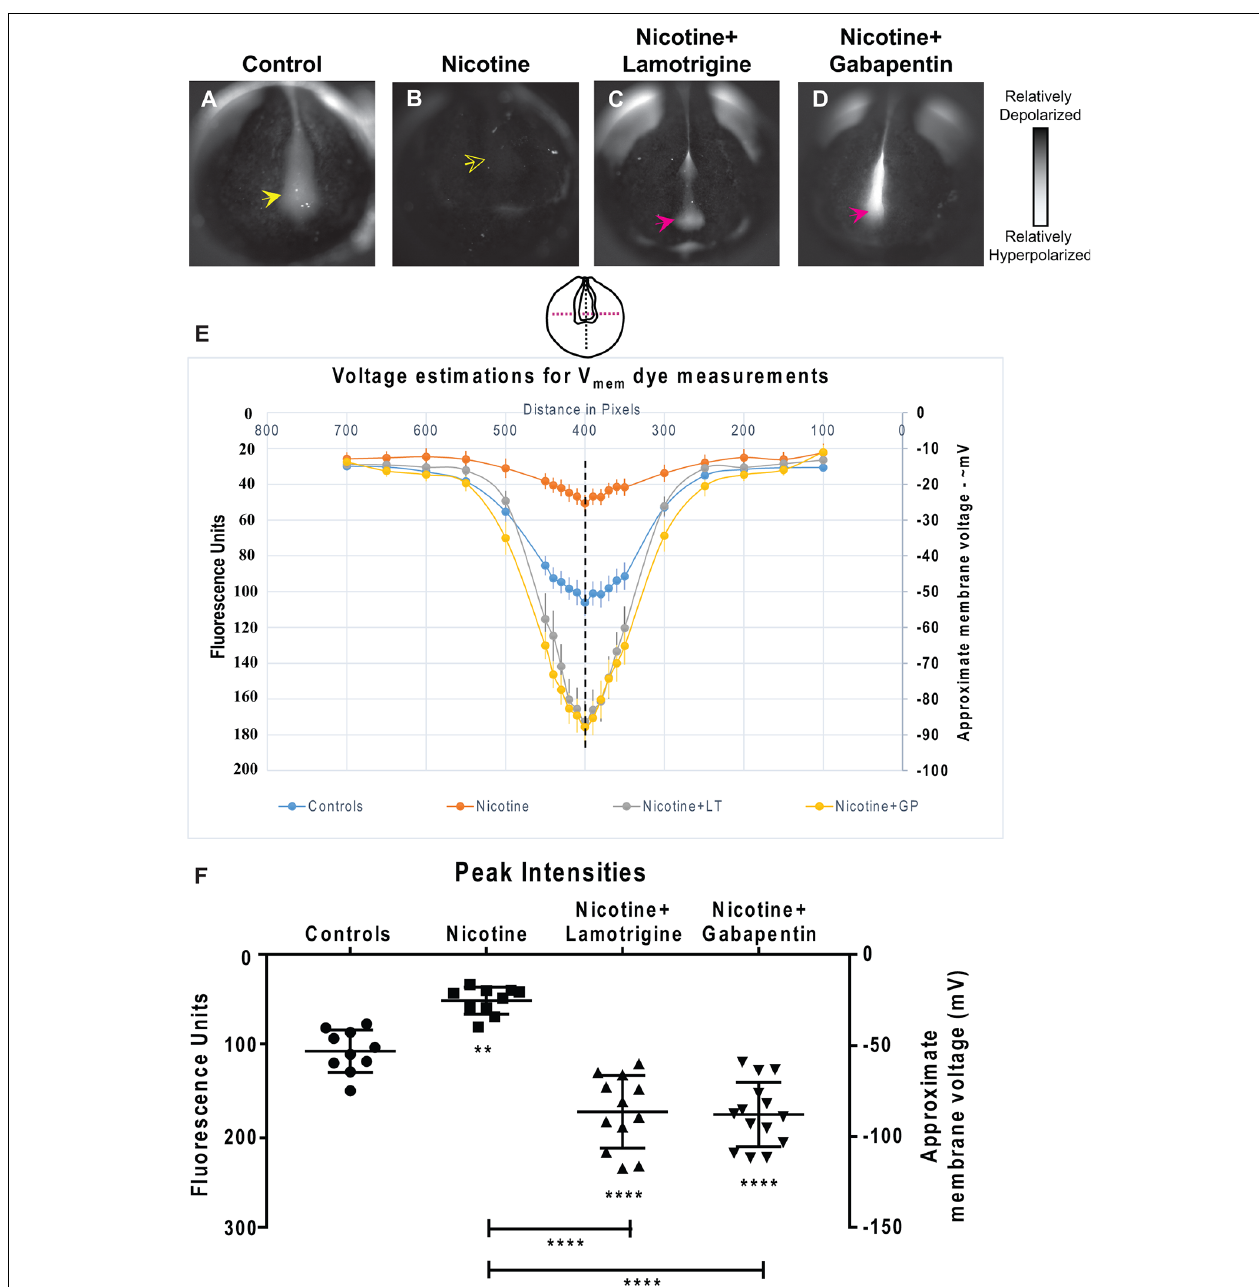
FIGURE 9 | Lamotrigine and Gabapentin restore neural development membrane voltage prepattern in nicotine-exposed embryos. (A–D) Representative CC2-DMPE membrane voltage reporter dye images of stage ∼ 15 Xenopus embryos: Control (untreated and uninjected) and nicotine-treated embryos with or without lamotrigine (stage 10 onwards) or gabapentin (stage 10 onwards) treatment. Solid yellow arrows indicate characteristic hyperpolarization in the neural plate as previously reported (Pai et al., 2015b, 2018). Hollow yellow arrows indicate significantly reduced signal (depolarization) within the neural plate in comparison to controls. Magenta arrows indicate significantly enhanced hyperpolarization in the neural plate compared to controls. (E,F) Quantification of fluorescence from CC2-DMPE images of stage ∼ 15 Xenopus embryos along with electrophysiology-based membrane voltage approximations [as previously reported in references (Pai et al., 2015b, 2018)] for the indicated conditions (LT-lamotrigine, GP-gabapentin). (E) Quantification obtained along the magenta dotted line indicated in the illustration. (F) Quantification at the point of intersection of the magenta and black dotted line indicated in the illustration. Data represented as mean ± SD, ** p < 0.01, **** p < 0.0001 (one-way ANOVA with Tukey’s post hoc test for N > 10 embryos for each treatment group at each point of the indicated spatial